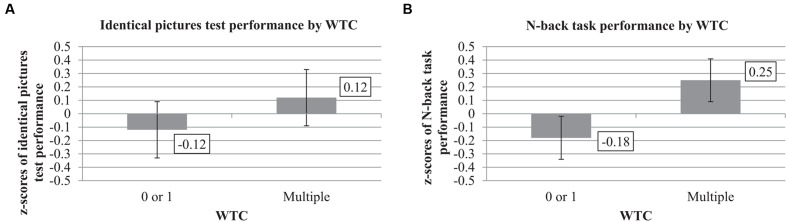
Identical pictures test and N-back performance by work-task changes (WTC) (adjusted for leisure-time activity and voluntariness in WTC; n = 38).
z-scores of performance in the identical pictures test (A), and N-back task (B) by multiple versus 0 or 1 WTC during 17 years. Error bars indicate standard errors.